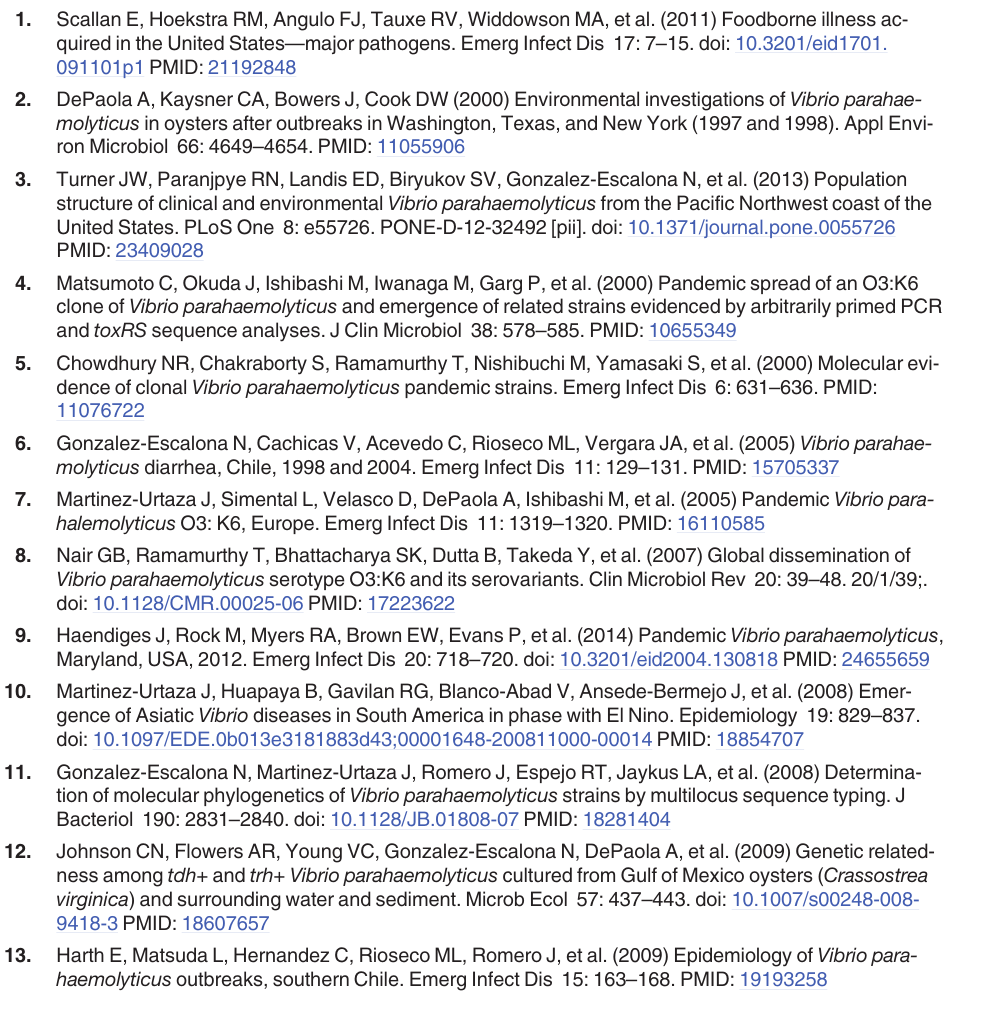
stringent criteria (6/7 shared alleles). CC345 can be seeing at the bottom. STs that are SLV of each other are shown connected by lines (black). DLV STs are shown as connected by gray lines. CC — Clonal Complex. Table A. V . parahaemolyticus genomes used in the whole ge- nome (wgMLST) comparator analysis